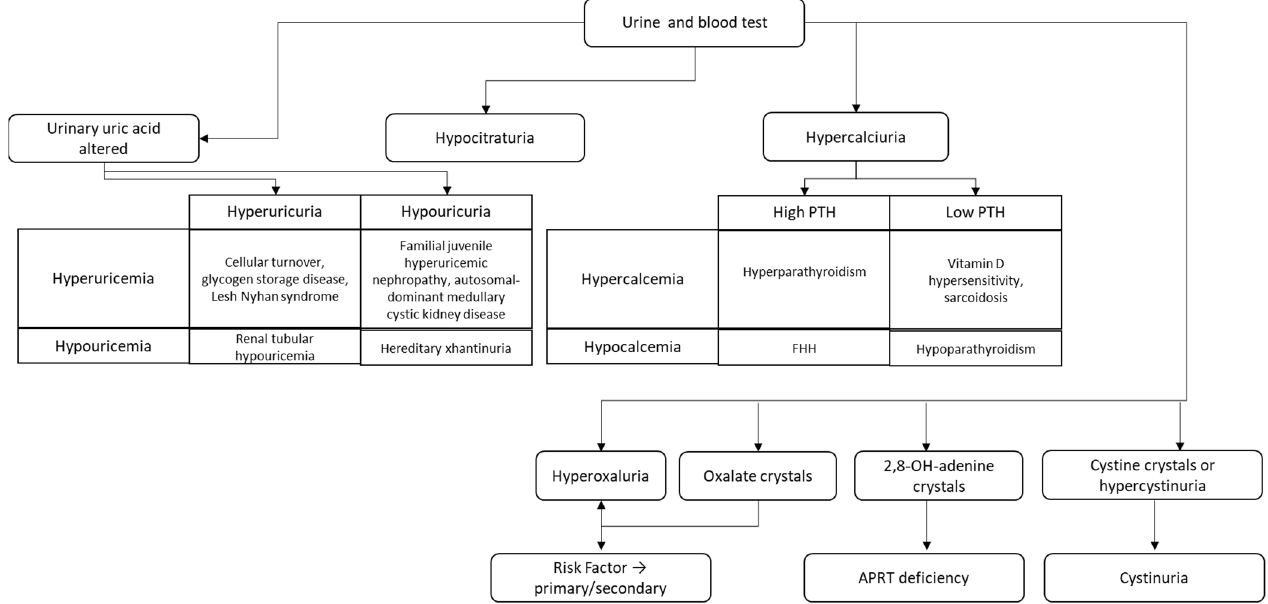
Figure 1. Algorithm to diagnose and evaluate pediatric urolithiasis, adapted from Marra et al. [46].